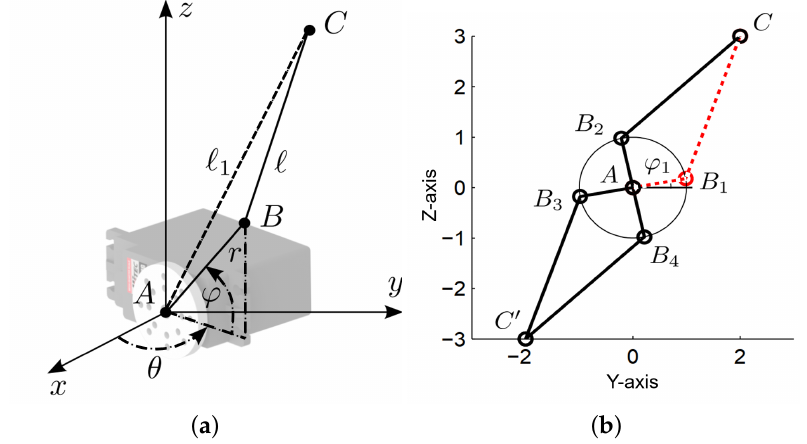
Figure 3. ( a ) Local coordinate frame for a servo control unit; ( b ) mapping of possible solutions for